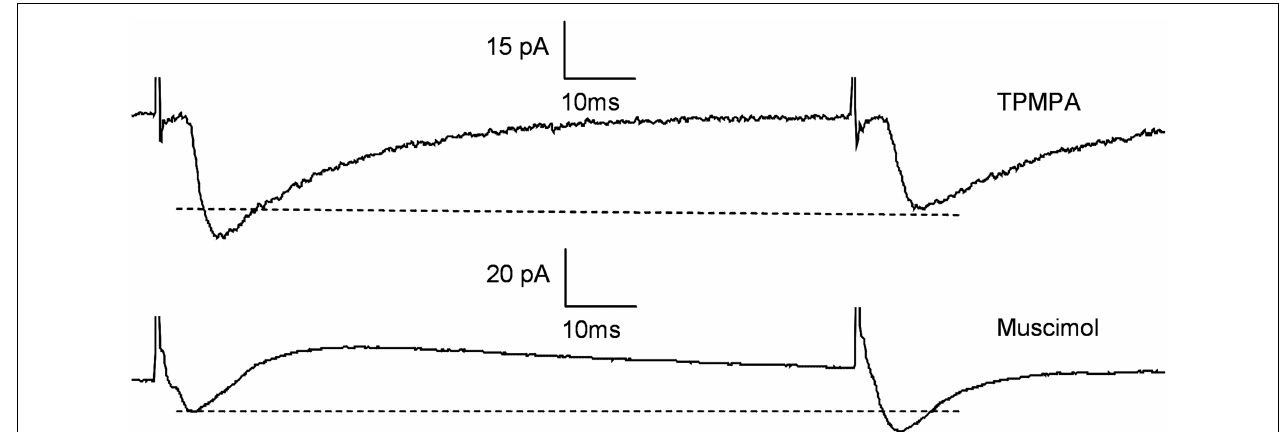
FIGURE 2 | Paired pulse depression was affected by muscimol and TPMPA Testing for paired pulse depression (PPD) in 12 Pyramidal cells by using an interstimulus interval of 100 ms. TPMPA increased the PPD of EPSCs by